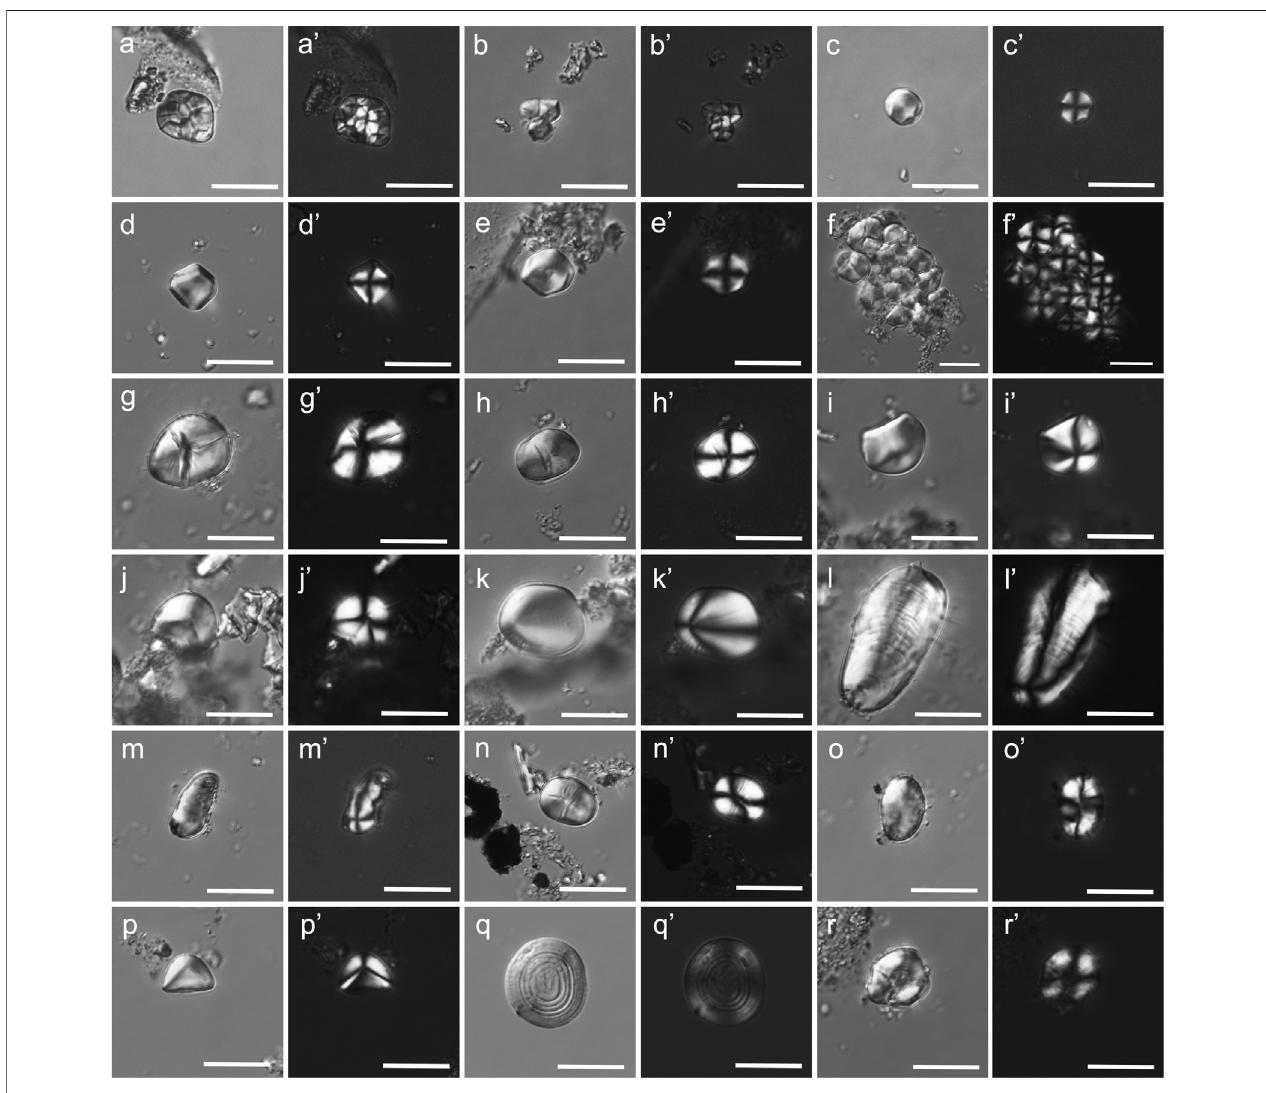
FIGURE 4 | Ancient starch grains identi fi ed on potsherds from the site of Houjiazhai — (a,a ’ ,b,b ’ ) rice; (c,c ’ ,d,d ’ ,e,e ’ ,f,f ’ ) foxtail millet, broomcorn millet, and probably small grains from Job ’ s tears; (g,g ’ ,h,h ’ ) Job ’ s tears; (i,i ’ ,j,j ’ ) root of snake gourd; (k,k ’ ) Chinese yam; (l,l ’ ) lotus root; (m,m ’ ) lily bulbs; (n,n ’ ,o,o ’ ) beans that may include Vigna sp. or/and Vicia sp.; (p,p ’ ) acorns; (q,q ’ ) seeds from Triticeae showing more pronounce lamellae; and (r,r ’ ) an example of a damaged starch grain (scale bar: 20 μ m).